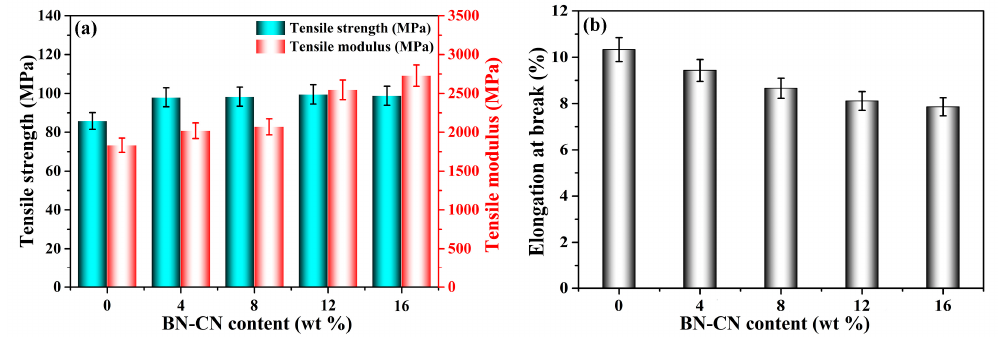
Figure 6. Tensile strength and tensile modus ( a ) and elongation at break ( b ) of the PEN-g-BN hybrids.